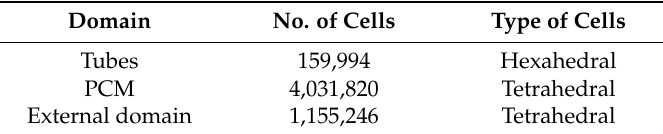
Table 5. Final mesh of the overall geometry.